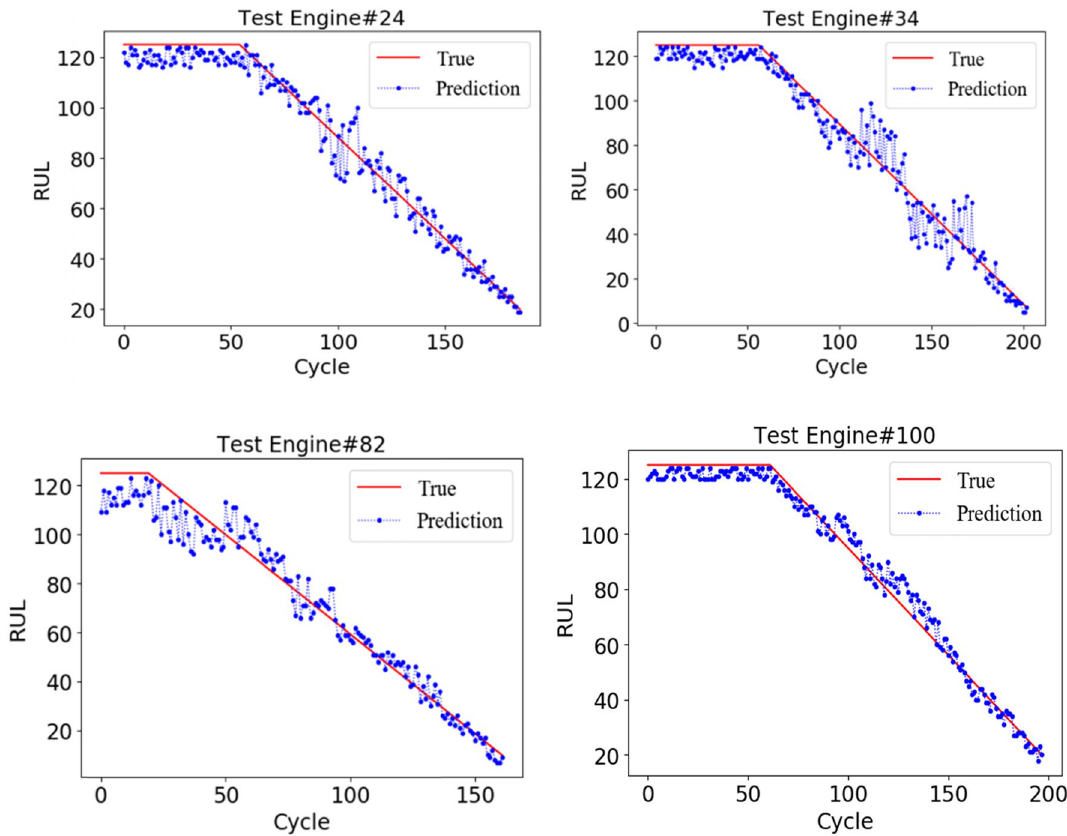
Figure 9. RUL prediction results of four monitoring units.